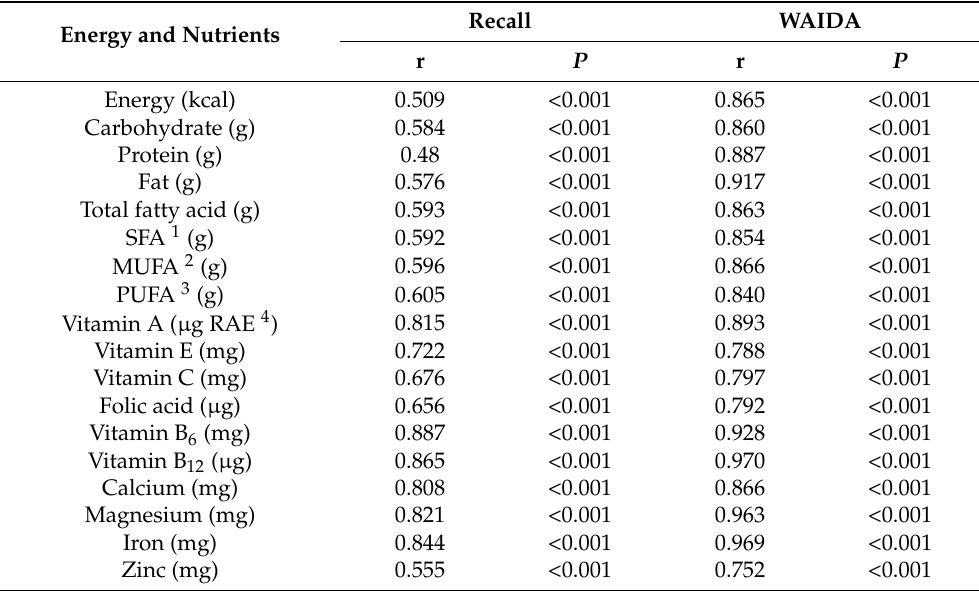
Table 4. Pearson correlation coefficients of energy and nutrient intakes from weighing method and those estimated by the recall or WAIDA method ( n = 251